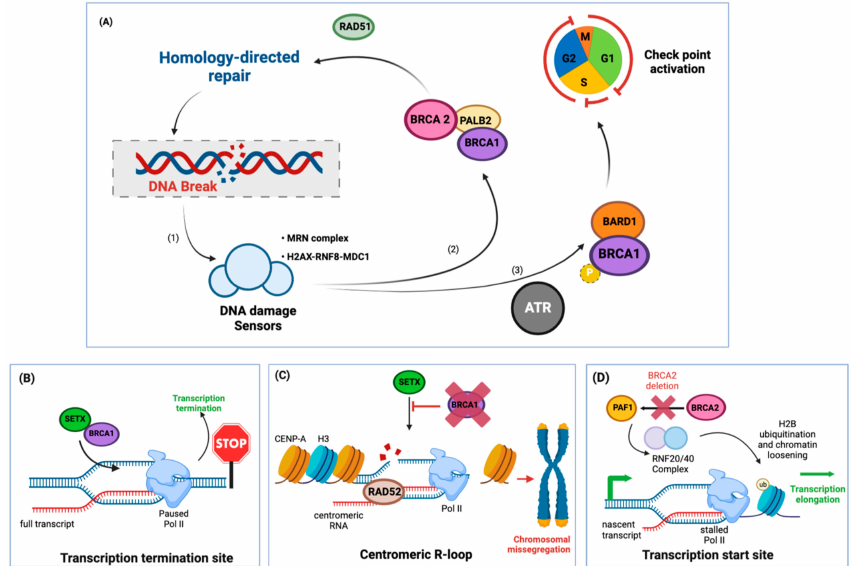
Figure 3. BRCA1/2 tumor suppressors protect the genome against DNA damage by resolving R-loops. ( A ) (1) DNA damage is detected by different DNA damage sensors such as the MRN complex, which senses double-stranded breaks, or the H2AX-RNF8-MDC1 complex, which recognizes histone ubiquitylation, which are installed proximal to sites of DNA damage [37]. (2) Upon its recruitment by DNA damage sensors, BRCA1 directly binds various damage response mediators such as Topoisomerase II binding protein 1 (TOPBP1) or BRCA1–partner and localizer of BRCA2 (PALB2) to form a complex with BRCA2 and initiate RAD51-dependent homologous recombination [37]. (3) ATR- or ATM-dependent phosphorylation of BRCA1, while it is in complex with the BRCA1-associated RING domain protein 1 (BARD1), induces cell cycle arrest to allow time for DNA repair; [37] ( B ) BRCA1 recruits senataxin (SETX) to unwind R-loops and enables transcription termination and the release of Pol II (RNA polymerase II) [32]. Loss of BRCA1 through mutations in cancer causes the accumulation of R-loops and can accelerate DNA damage; ( C ) Loss of BRCA1 activity impairs the recruitment of senataxin to centromeric R-loops, leading to unresolved R-loops and the subsequent accumulation of Rad52-dependent hyper-recombination, centromere breakage, micronuclei formation, and chromosomal missegregation [38]; ( D ) BRCA2 mediates the release of stalled Pol II through recruitment of PAF1 (RNA polymerase II-associated factor 1) [34,39]. In turn, PAF1 recruits the RNF20/40 E3 ubiquitin ligase complex to ubiquitinate histone subunit 2B. This modification enables histone dissociation and Pol II access to the downstream sequence, resolving Pol II stalling. Disruption of this process by BRCA2 deletion or inactivation, as often found in cancer, results in R-loop and